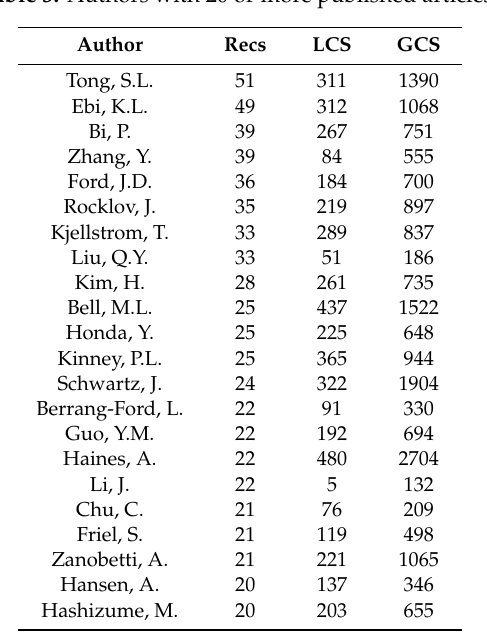
Table 3. Authors with 20 or more published articles.